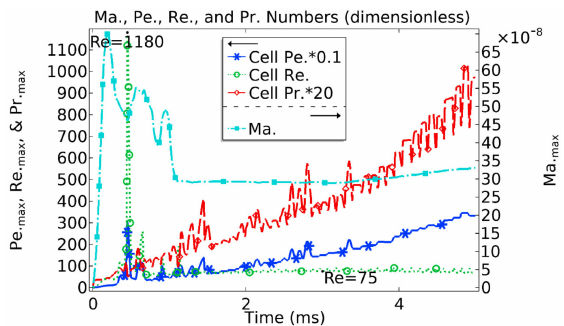
Figure 5. Maximum of cell Peclet number (Pe), Mach number ( Ma ), cell Reynolds number (Re), and cell Prandtl number (Pr) for the whole of simulation in 200 A peak arc.